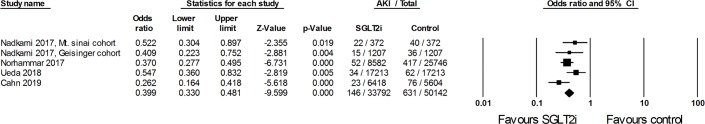
Effect of SGLT2is on AKI in observational cohort studies.AKI, acute kidney injury; CI, confidence interval; SGLT2i, sodium-glucose cotransporter-2 inhibitor.